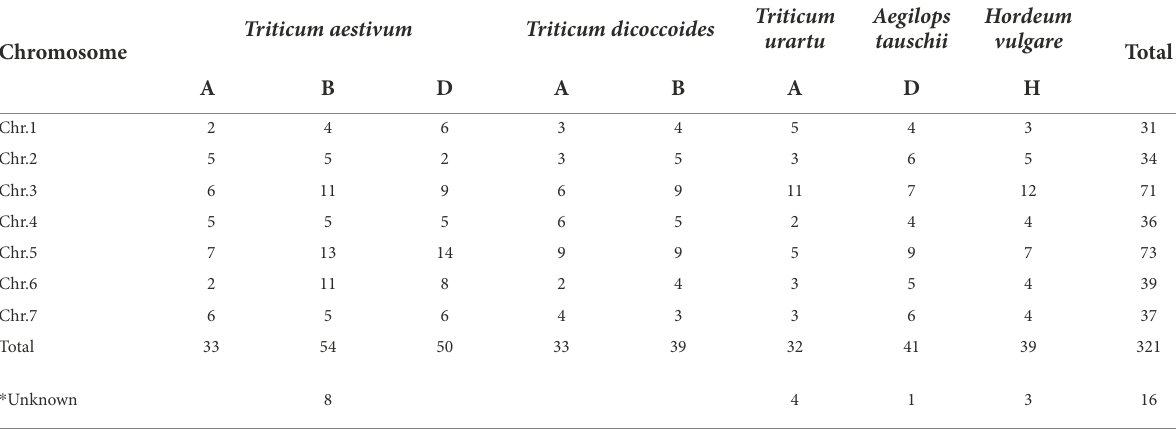
TABLE 2 Numbers of ANKTMs from different Triticeae species in each of the chromosomes.